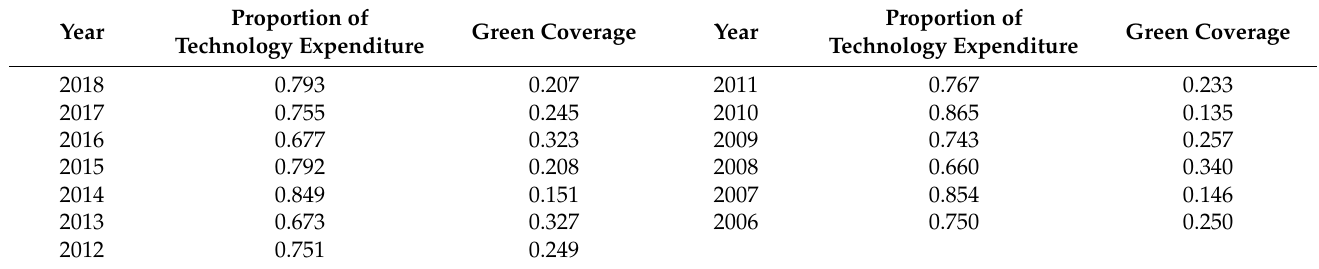
Table A4. Weight of government